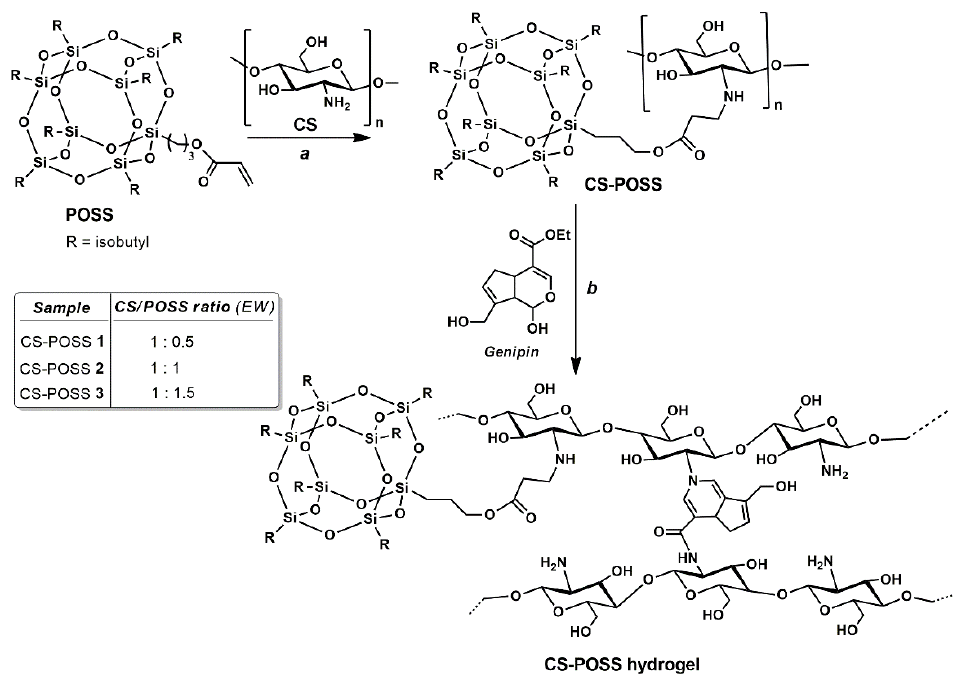
Scheme 1. Synthesis of CS-POSS hybrid hydrogels. Reagents and conditions: ( a ) acetic acid 2%, 50